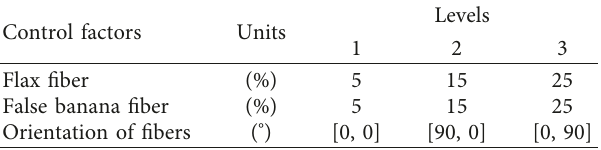
Table 3: Control factors and their levels.